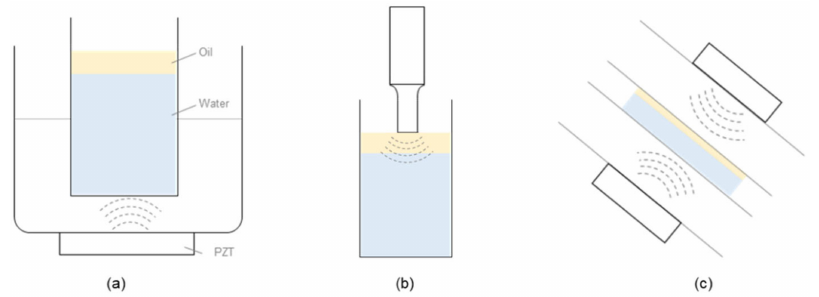
Figure 1. Three methods for ultrasonic emulsification: ( a ) bath-, ( b ) horn-, and ( c ) focused-type ultrasonic systems